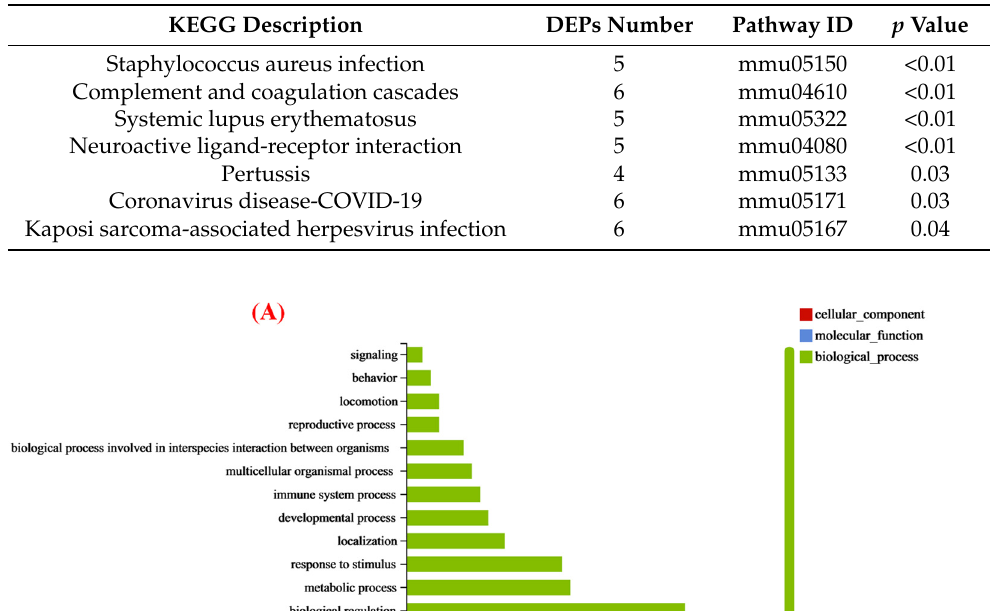
Table 2. Results of KEGG enrichment analysis of differentially expressed proteins in hippocampus.